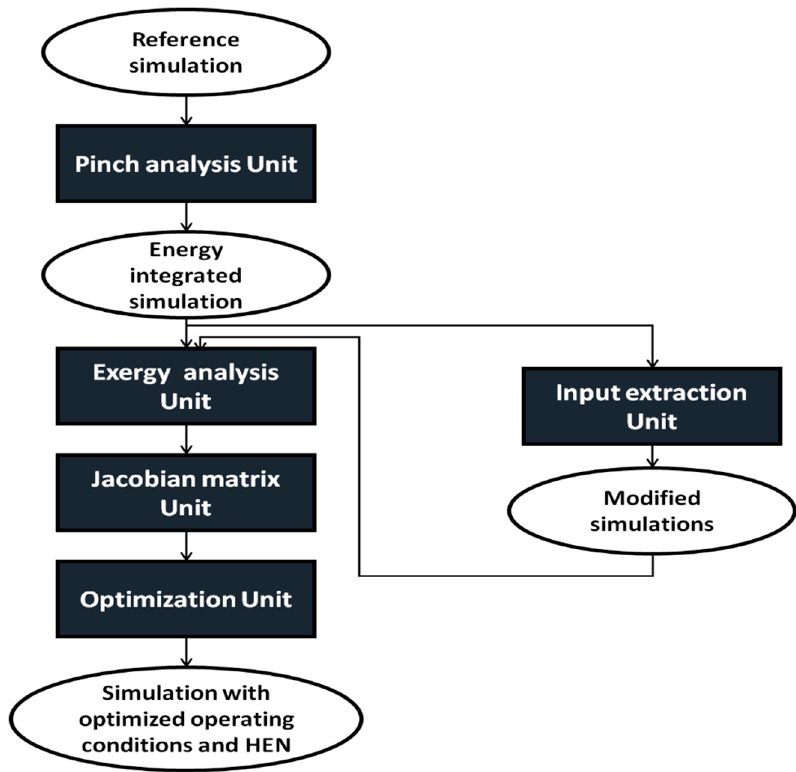
Figure 2. Framework of the operating conditions optimization (OCO) module.